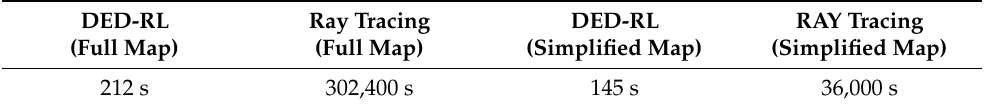
Table 3. Comparison of computation time and speed-up gain of DED-RL vs. ray tracing for site A000127C in the San Francisco